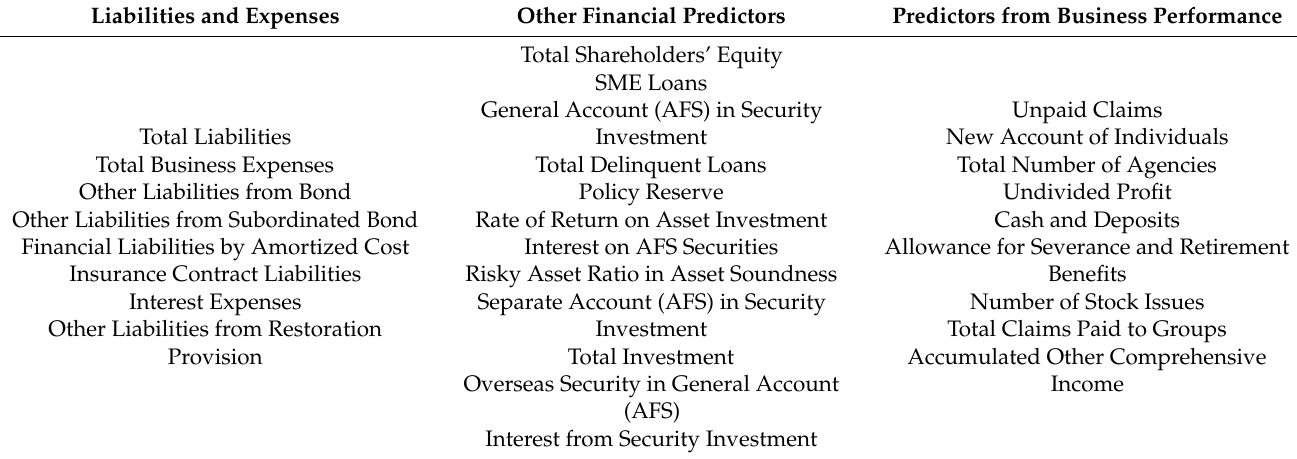
Table 6. Three Categories of Predictors found by Machine Learning